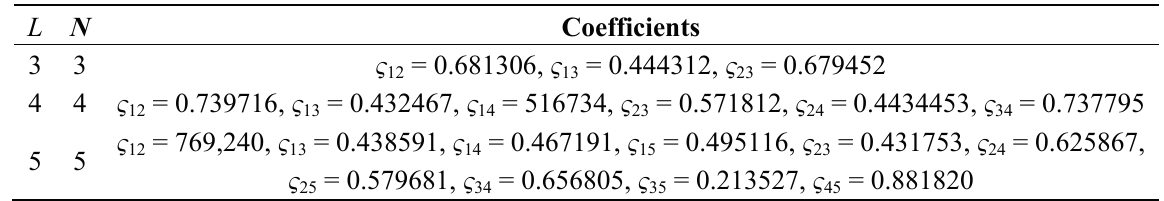
Table 10. LMSuc algorithm coefficients.